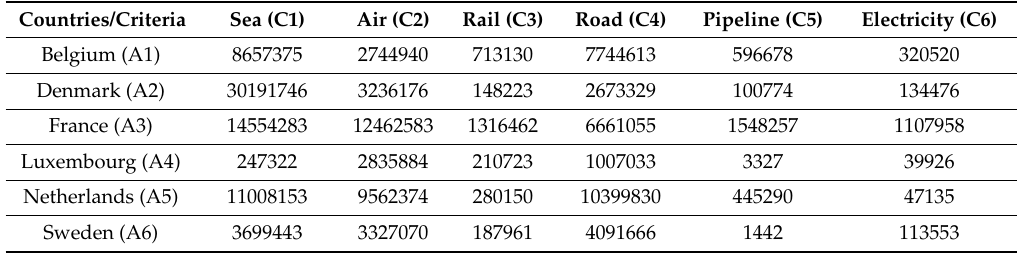
Table A2. Selected Data of Transport Export for the EU by 2015 (US Dollar, Thousand).